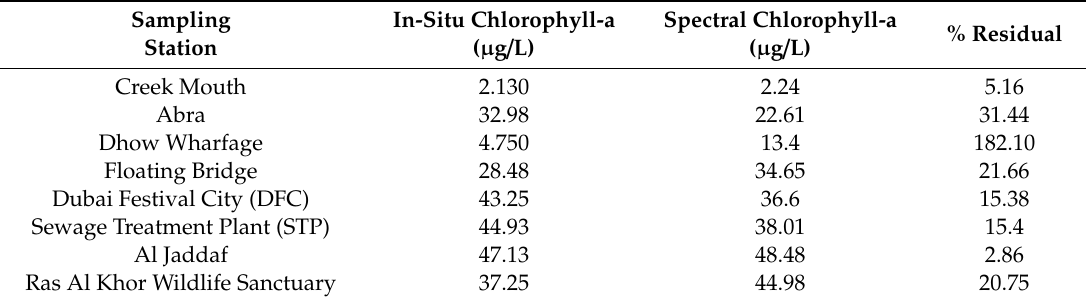
Table 3. Comparison of the in-situ and spectral chlorophyll-a concentrations computed by “(CB + NIR1) / NIR2”